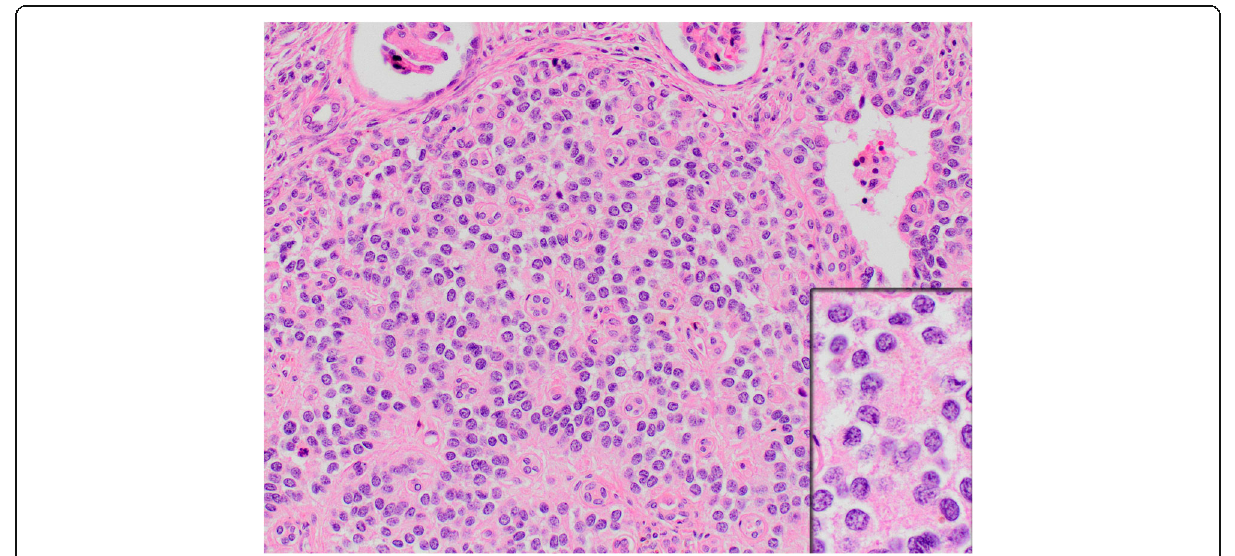
Fig. 2 Rosette or tubule-like formations (H&E × 200; inset : H&E ×